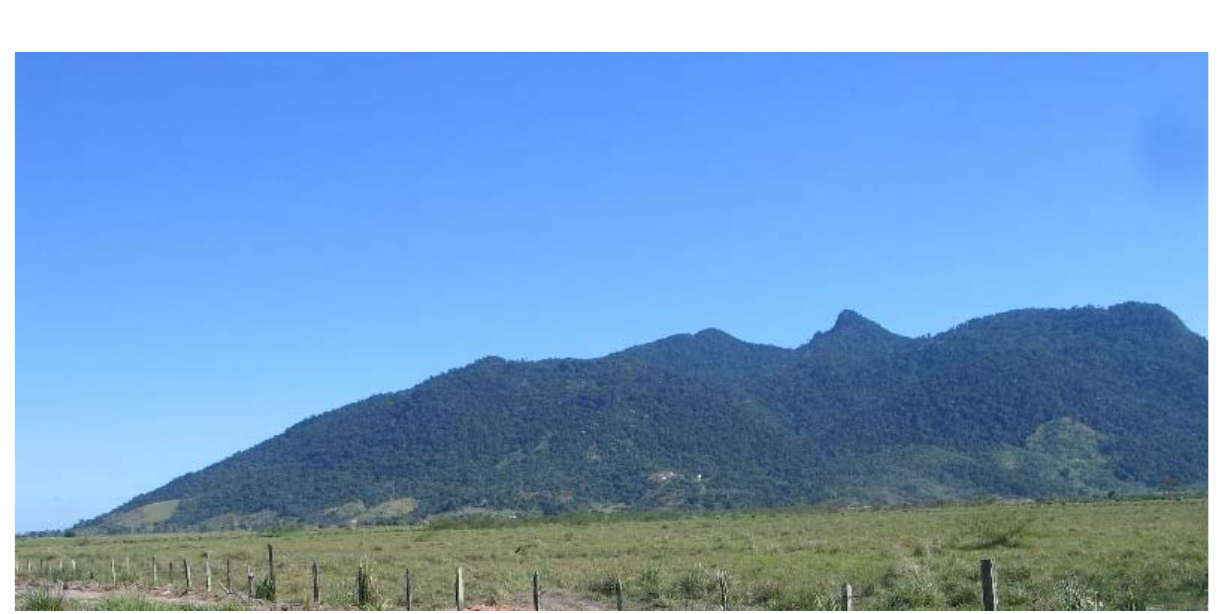
Figure 1 . View of the Morro São João, in Casimiro de Abreu, state of Rio de Janeiro. Photo by C. F. D. Rocha.